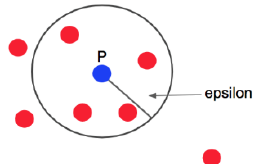
Figure 3. Density-based spatial clustering of applications with noise technique (DBSCAN) detection.